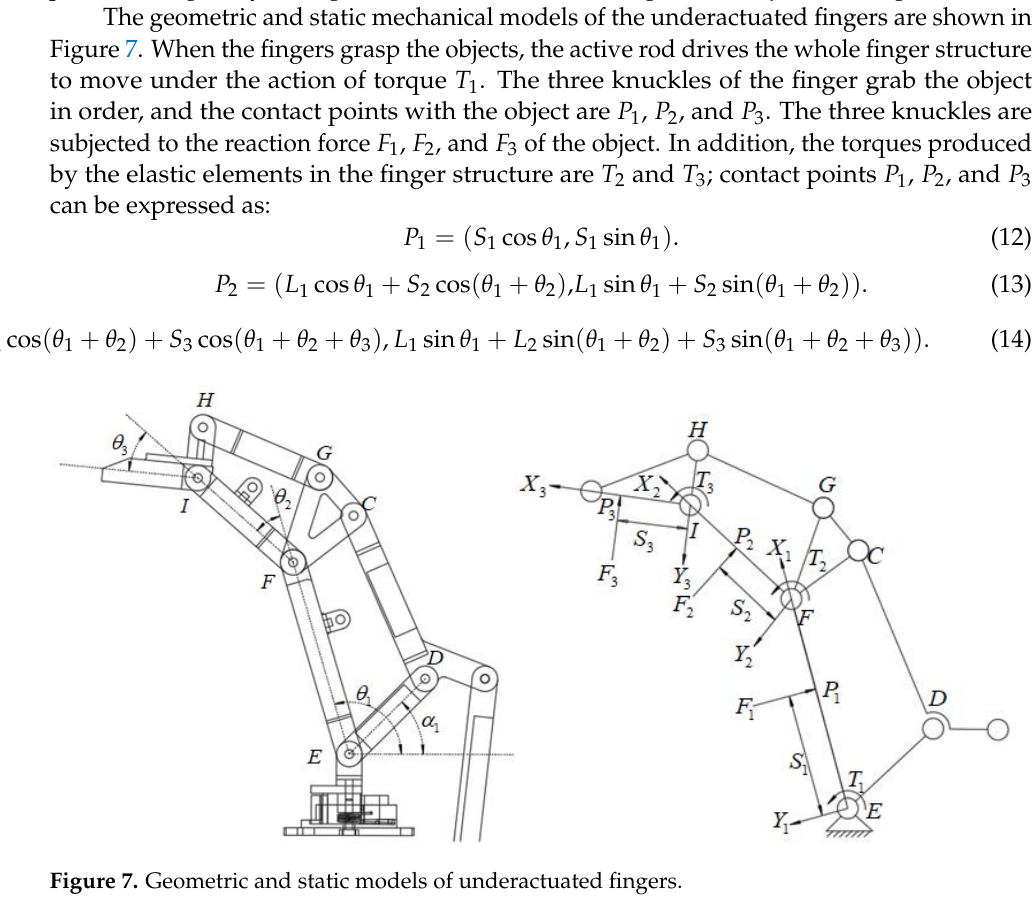
Figure 8. The functional relationship between variables 3 S , 3 θ , and 3 F . As shown in Figure 8, the contact force